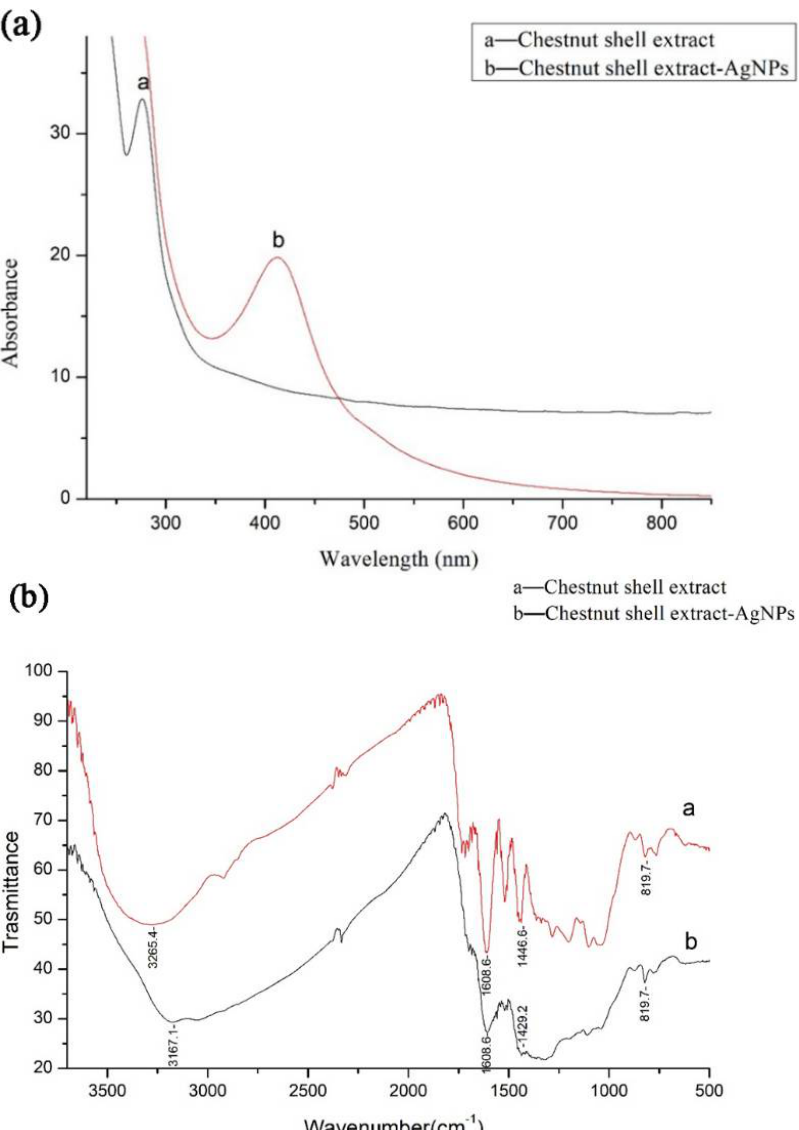
Figure 1. ( a ) The typical UV absorption spectrum of the functionalized chestnut-shell-extract AgNPs (chestnut shell extract solution was also measured for comparison) ( b ) FTIR spectra of the functionalized chestnut-shell-extract AgNPs (chestnut shell extract was also measured for comparison).